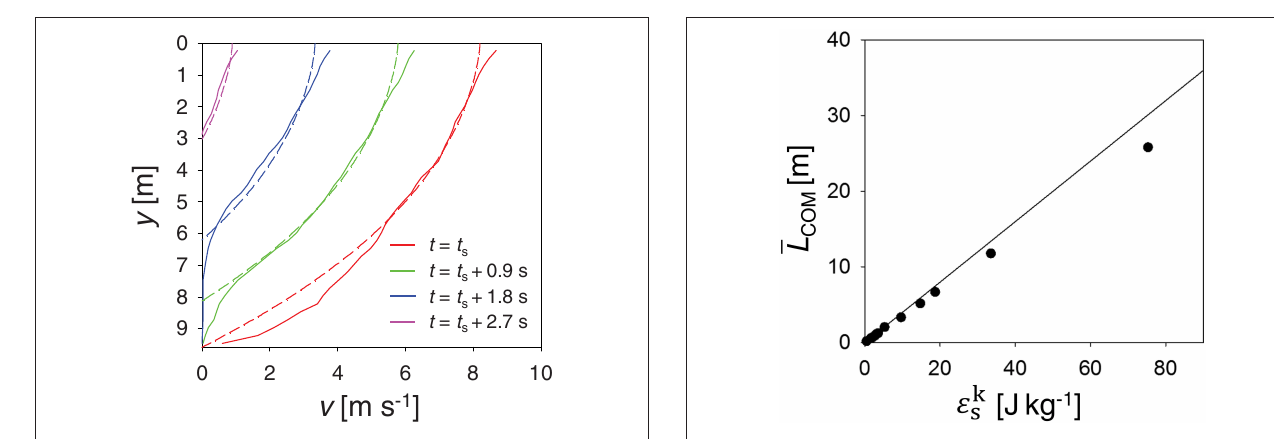
FIGURE 5 | Center of mass runout on the flat plane as a function of the kinetic energy achieved on the slope. Simulation results (points) were obtained for various slope lengths H / sin θ 10 100 m and landslide = − thicknesses h 1.2 9.6 m. The line denotes Equation (19), i.e., a = − deceleration distance derived for rate independent friction coefficient µ 0